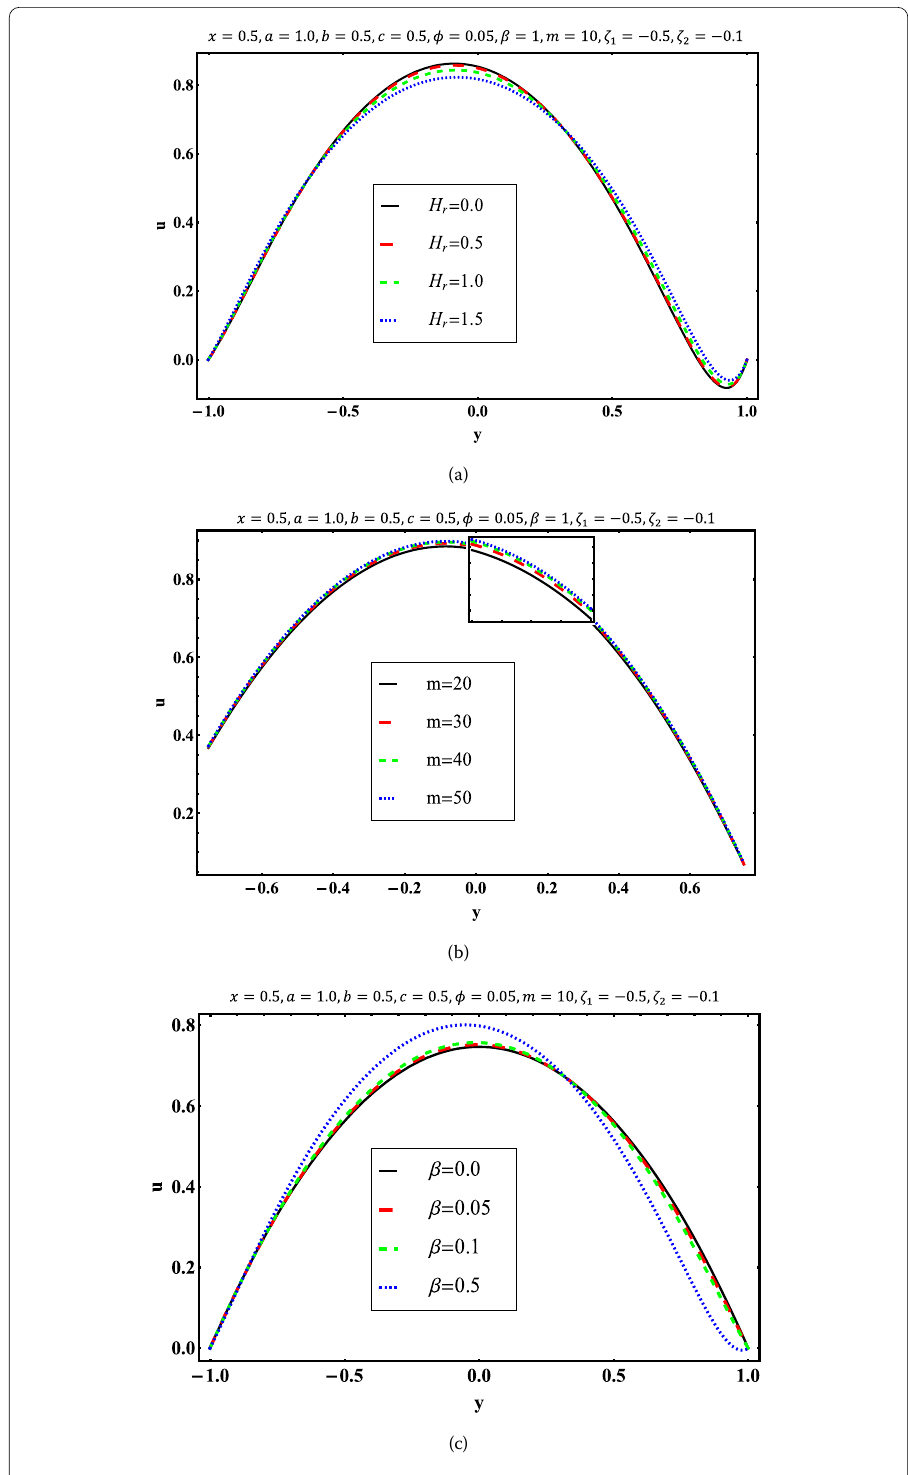
Figure 2 Variation of axial velocity u vs.: ( a ) H r , ( b ) m , ( c ) β , ( d ) ζ 1 , and ( e ) ζ 2